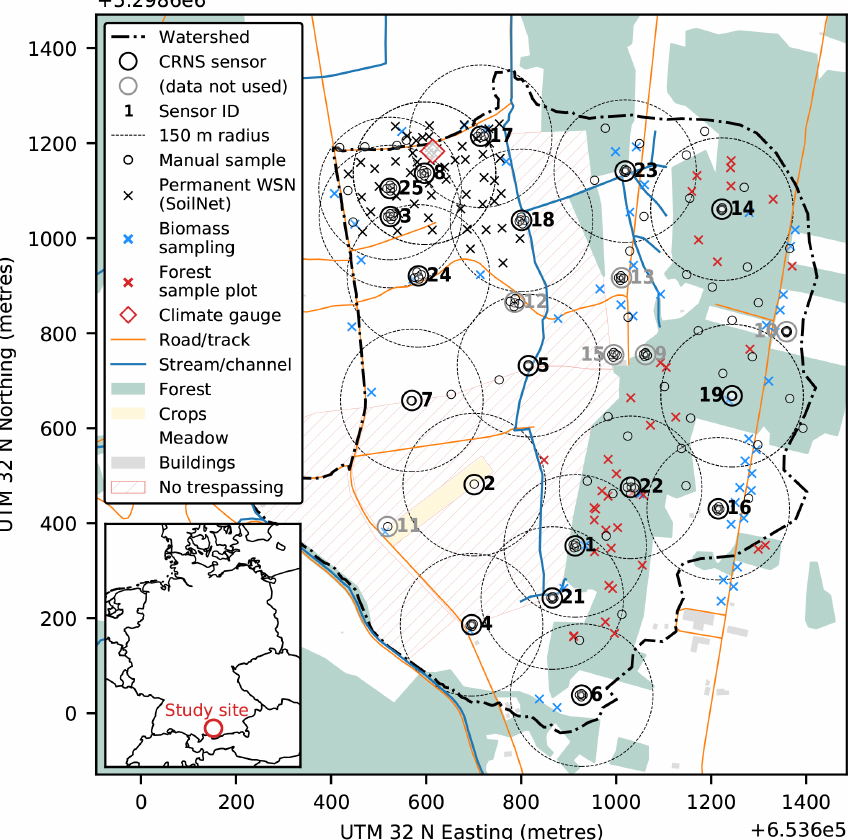
Figure 1. The study area around Fendt, in the headwater catchment of the Rott River. With regard to land cover, the forest, a few settlements, and a cropland plot are highlighted; the rest is mostly grassland. For instrumentation, we show the locations of the CRNS sensors, which have a typical footprint radius of 150m (Schrön et al., 2017)), as well as the locations of the climate gauge, the soil moisture measurements from the SoilNet, and the manual measurement campaign from 25 to 26 June 2019. Regarding the latter, five manual measurements were typically carried out in the close vicinity of each CRNS sensor, which is difficult to resolve in this map; the figure uses OSM basemap layers for waterways, land use, and roads (© OpenStreetMap contributors 2021; distributed under the Open Data Commons Open Database License (ODbL) v1.0) (OpenStreetMap contributors,